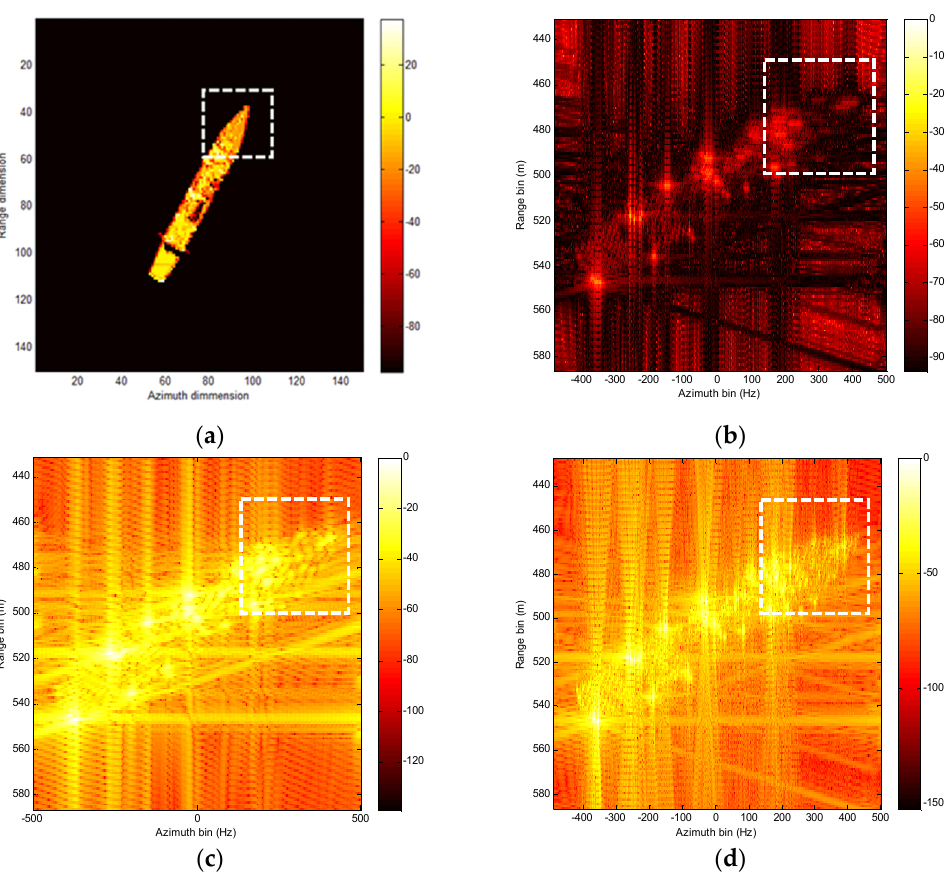
Figure 14. Imaging results for the destroyer. ( a ) RCS model of the destroyer. ( b ) Imaging results with RD algorithm. ( c ) Imaging results with the PGA method. ( d ) Imaging results with our proposed method. Table 3. Image entropy of corresponding imaging method